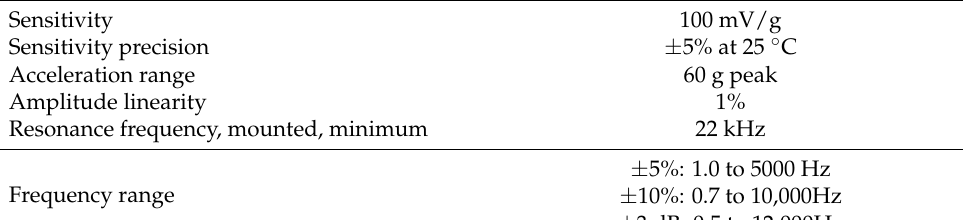
Table 3. SKF CMS 2200T sensor